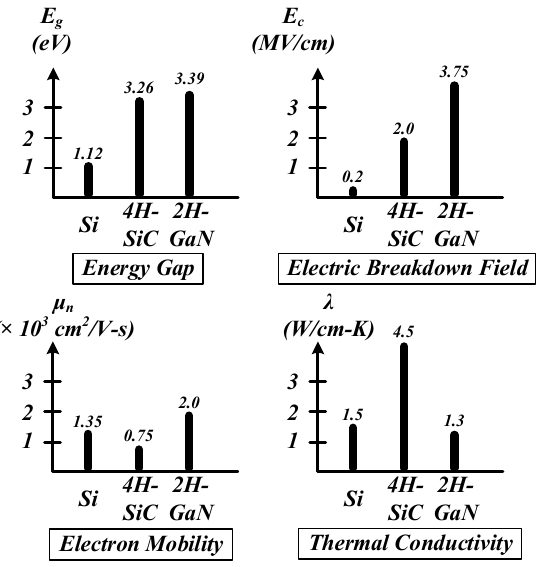
Figure 1. Electrical properties of Si, 4H ‐ SiC, 2H ‐ gallium nitride (GaN).